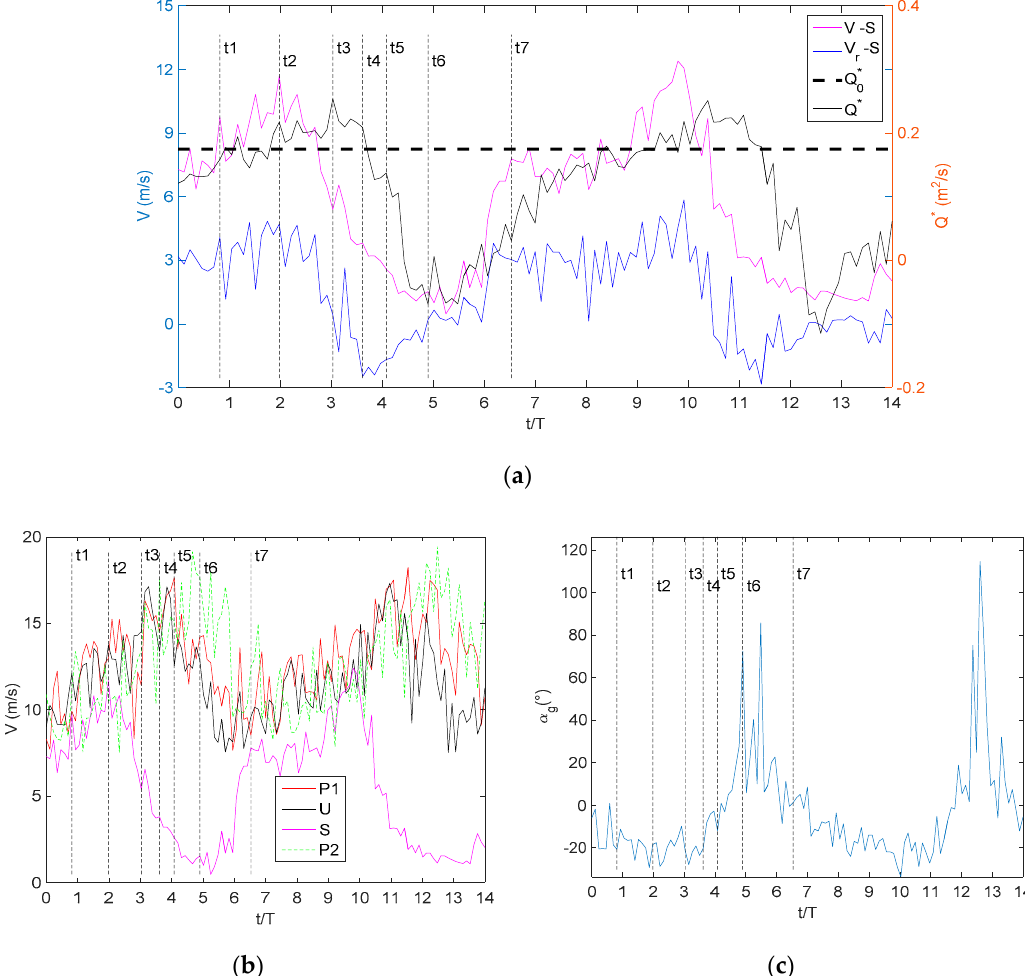
Figure 5. History of flow parameters within the measured zone when rotating stall appeared at z2 working condition at 18 mm opening. ( a ) Time history of two-dimensional flow Q* crossing the G line within Passage 2 and flow velocity at point S and its radial direction component; ( b ) Time history of flow velocities at points P1, P2, U and S; ( c ) Time history of angle of attack α g of the approaching flow to GV2.